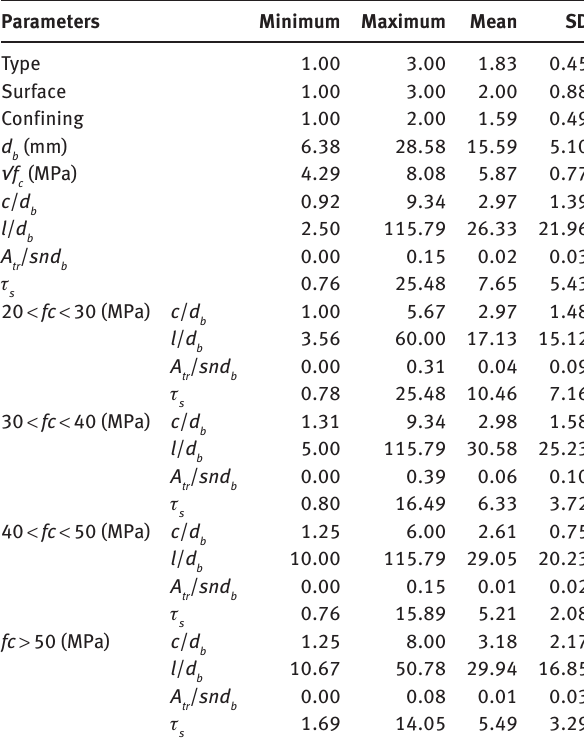
Table 1: Ranges of input and output parameters in the database.